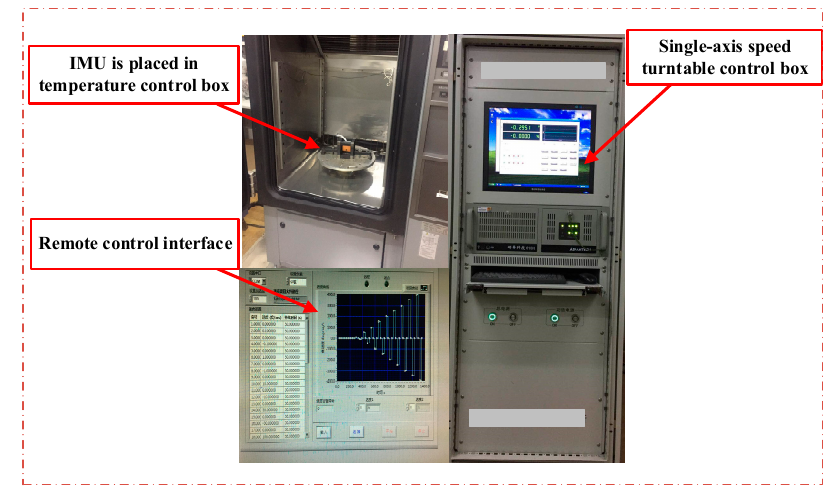
Figure 3. Block diagram of the test device.